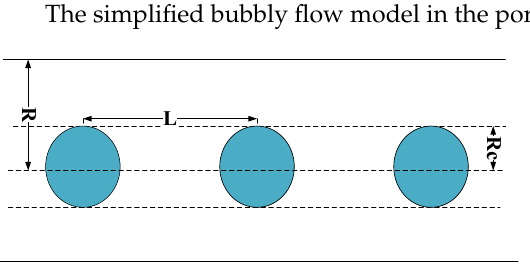
Figure 1. Bubbly flow in the pore.